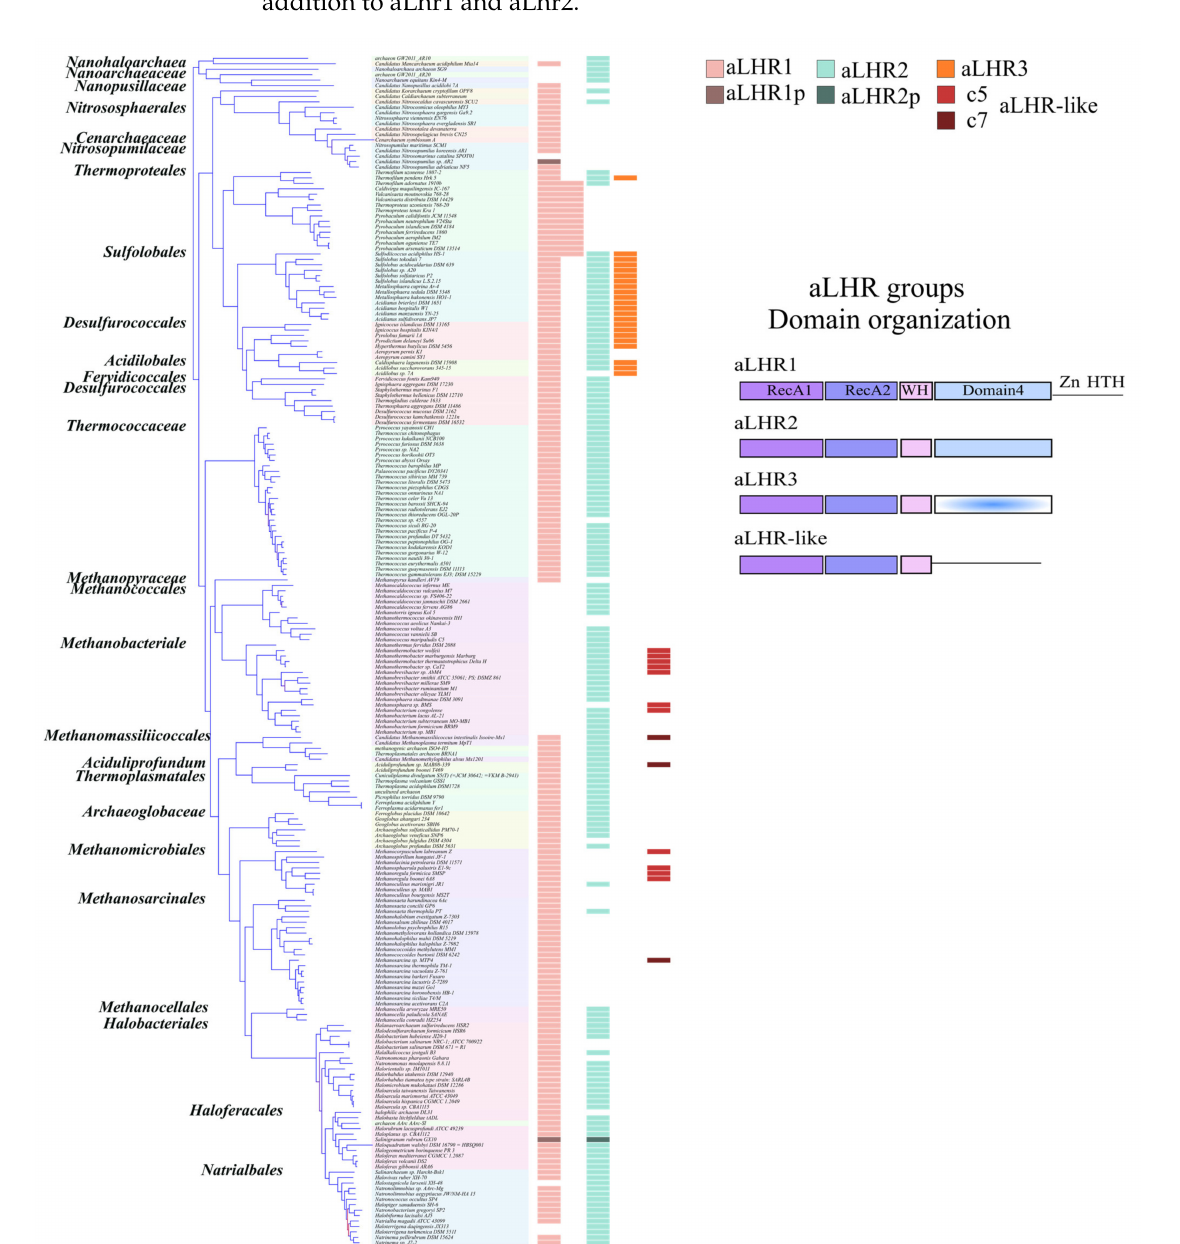
Figure 3. Distribution and domain organization of Lhr groups in Archaea. Left panel: the species tree of the archaeal genomes was deduced from sets of 120 concatenated sequence alignments with fasttree [30] using LG + GAMMA models and support values determined using 100 non-parametric bootstrap replications (lower bootstrap supports are indicated by red branches). The tree was rooted on DPANN Archaea according to [31]. NCBI taxonomy was reported at the order or family level. The distribution of aLhr groups is displayed as bar charts, whose width is proportional to the number of paralogues in each genome (0, 1 or 2). The darker marks in the aLhr1 and aLhr2 column indicate the presence of pseudogenes and are figured as aLhr1p and aLhr2p. The c5 and c7 correspond to archaeal aLhr-like proteins. Right panel: the domain architecture is represented for each archaeal aLhr family. The SF2 helicase core is shown in light and dark violet, WH domain in pink and Domain 4 in light blue. aLhr1 architecture shows an additional C-terminal domain containing a conserved Zn-finger like and HTH motifs; aLhr2 is restricted to the “Lhr core”; aLhr3 has a deteriorated Domain 4 (in gradient blue) and aLhr-like misses a Domain